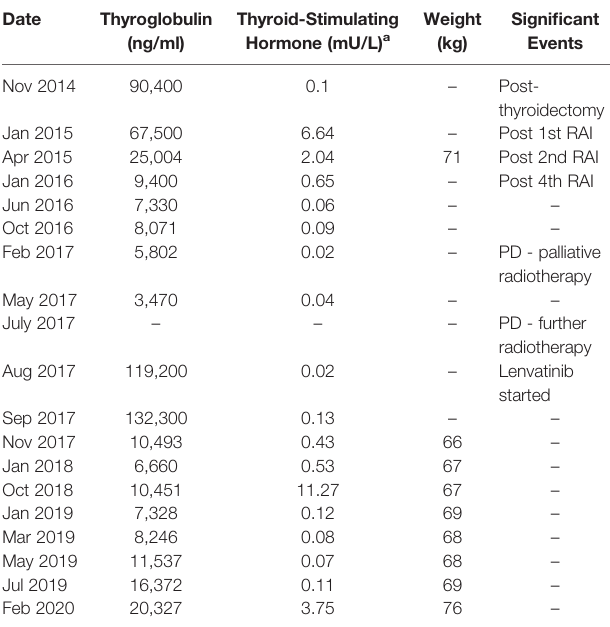
TABLE 1 | Patient Characteristics Over